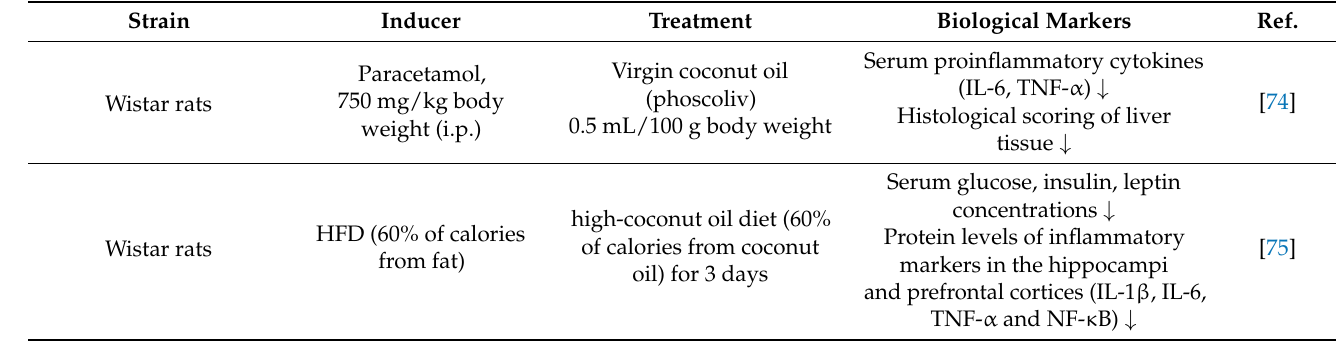
Table 7. Effects of coconut oil in animal models with metabolic